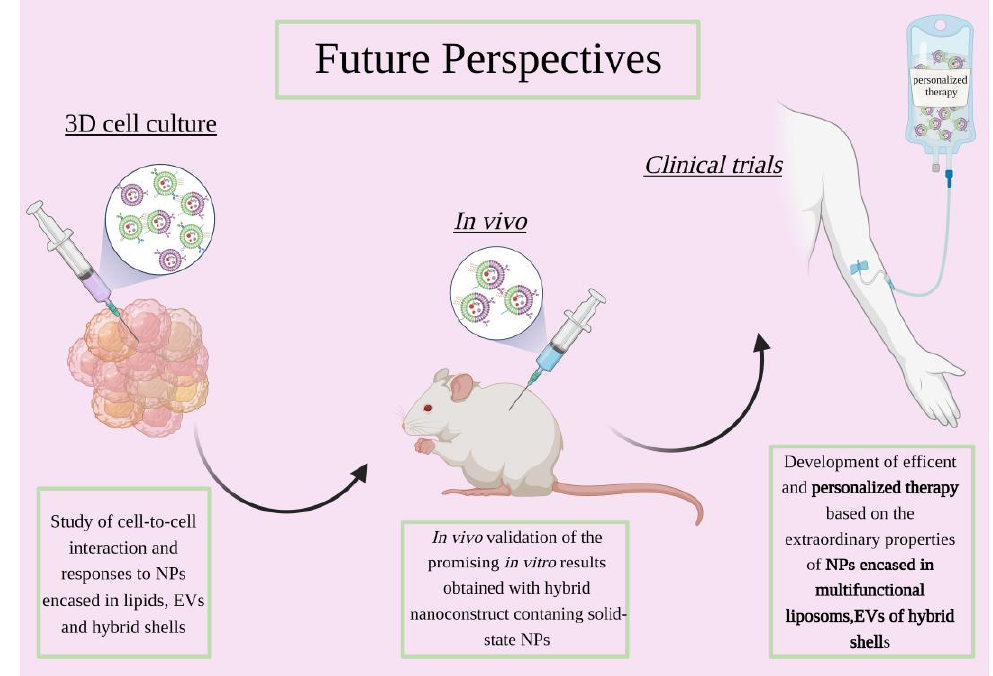
Figure 4. Scheme showing the future perspective of anticancer research involving solid-state nanoparticles enclosed in lipidic-based shells, extracellular vesicles or engineered hybrid vesicles. Created with BioRender.com, accessed on 26 October 2022.